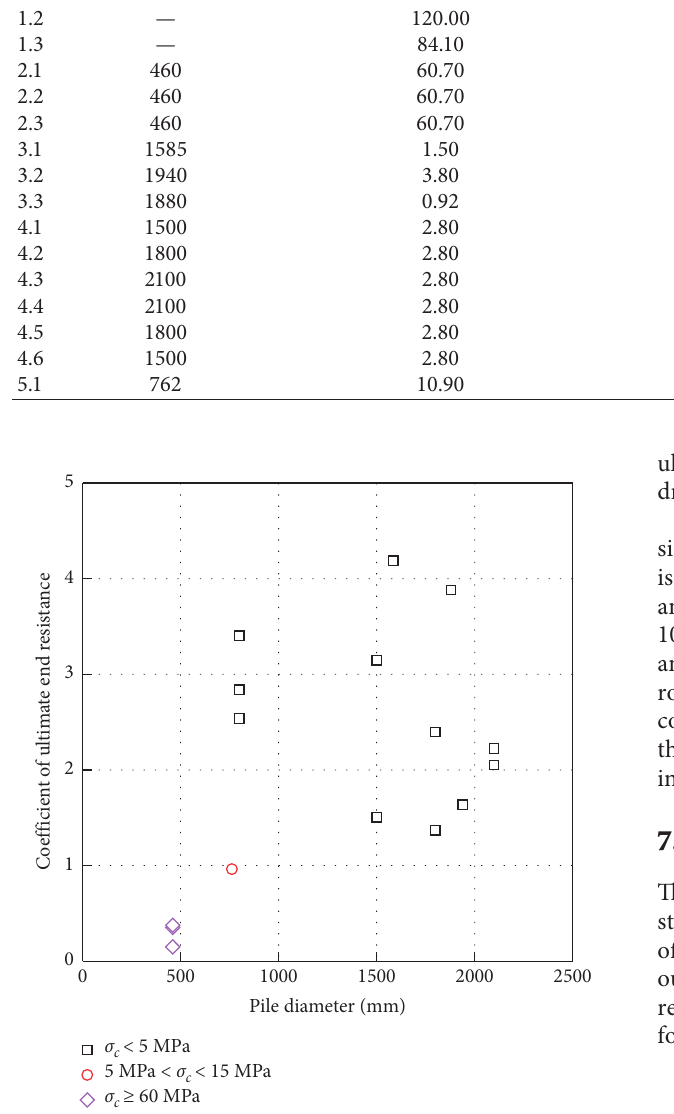
Figure 8: Relationship between pile diameter and coefficient of ultimate end resistance.